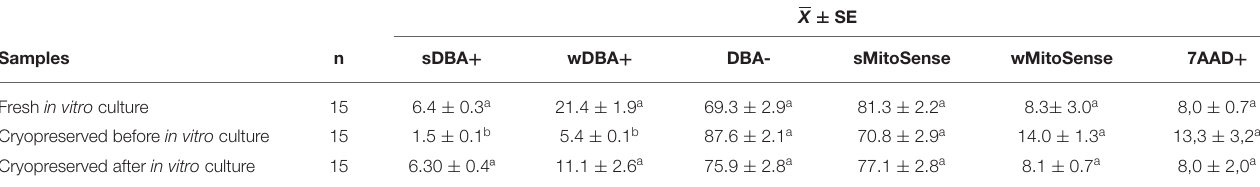
TABLE 5 | Mean percentage of spermatogonial stem cell before and after in vitro culture and freeze in MSDB freezing medium.